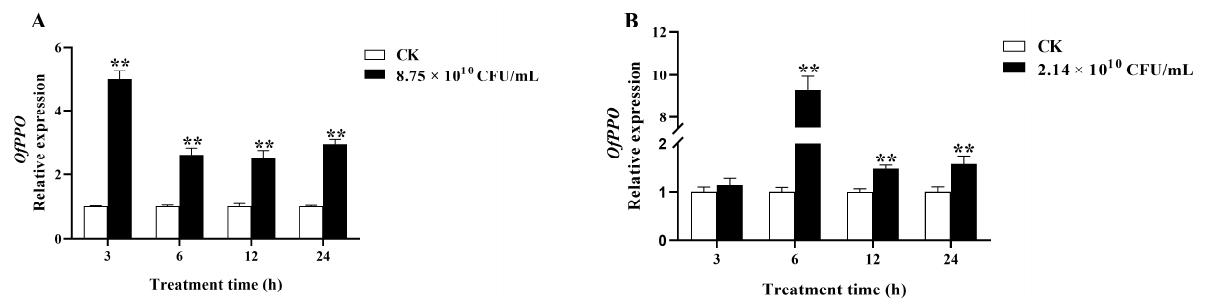
Figure 5. Elevated OfPPO expression in O. formosanus workers infected by SM1 ( A ) and Bt ( B ). The data are presented as the mean ± SD of three replicate samples. The asterisks indicate significant differences between the treatment groups and the control groups (** p < 0.01).